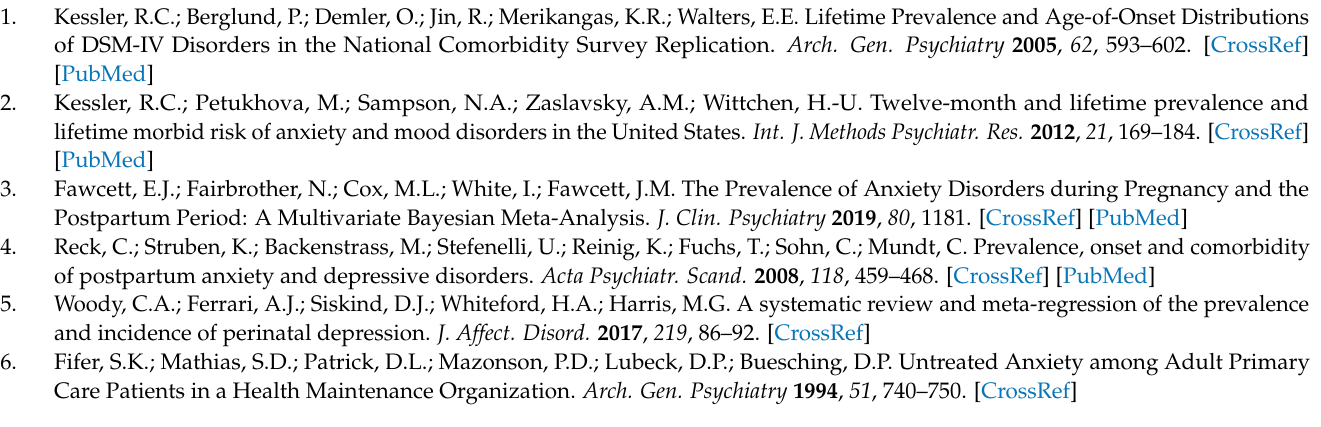
curves for the Childbrith Fear Questionnaire (CFQ) across parity (full diagnostic criteria ONLY). Figure S2: ROC curves for the CFQ (Total and Interference Subscale scores) across parity (full diagnostic criteria ONLY). Figure S3: ROC curves for the Wijma Delivery Expectations Questionnaire (W-DEQ) across parity (full diagnostic criteria ONLY). Figure S4: ROC curves for the CFQ across parity (subclinical and full diagnostic criteria combined). Figure S5: ROC curves for the CFQ (Total and Interference Subscale scores) across parity (subclinical and full diagnostic criteria combined). Figure S6: ROC curves for the W-DEQ across parity (subclinical and full diagnostic criteria combined). Figure S7: ROC curves for the CFQ across parity, separately for fear of vaginal birth (subclinical and full diagnostic criteria combined). Figure S8: ROC curves for the CFQ across parity (Total and Interference Subscale scores), separately for fear of cesarean birth (CS; subclinical and full diagnostic criteria combined). Figure S9: ROC curves for the W-DEQ across parity, separately for fear of vaginal birth (subclinical and full diagnostic criteria